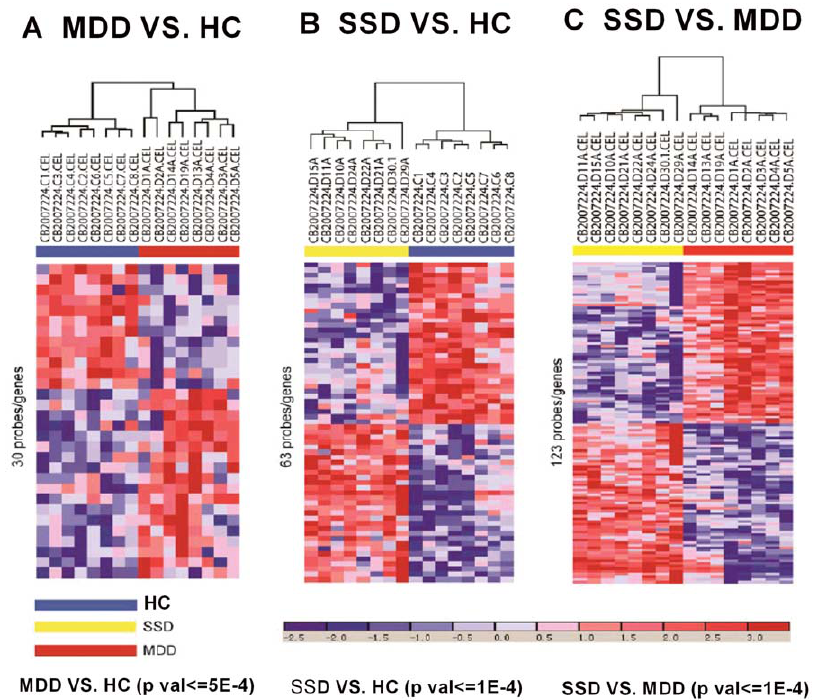
Figure 2. Biomarkers differentiation efficiency among MDD group, SDD group and HC. (A) Complete linkage clustering analysis with 16 samples using 30 biomarkers under the criteria of adjusted.P , =5E-4 between MDD and HC. (B) Complete linkage clustering analysis with 16 samples using 63 biomarkers under the criteria of adjusted.P , =1E-4 between SSD and HC. (C) Complete linkage clustering analysis with 16 samples using 123 biomarkers under the criteria of adjusted.P , =1E-4 between SSD and MDD. MDD: Major depression disorder; SSD: Subsyndromal symptomatic depression; HC: Healthy controls.